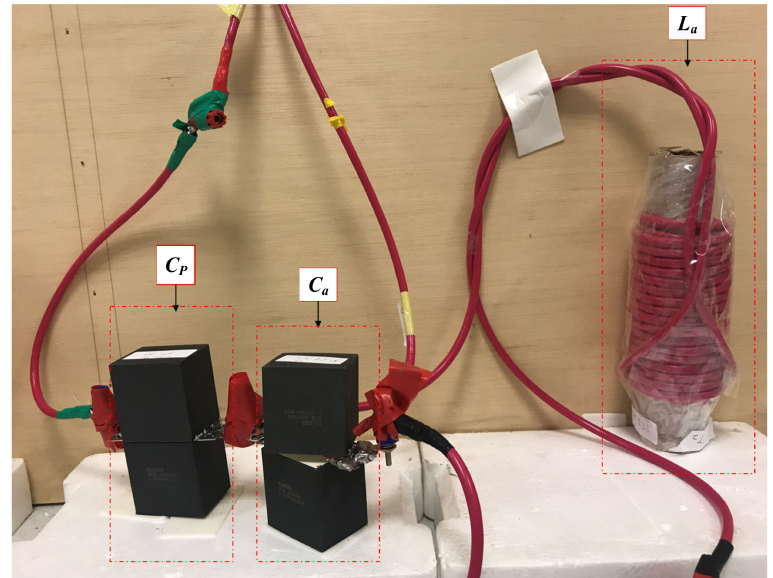
Figure 12. One typical inductor-capacitor-capacitor (LCC)